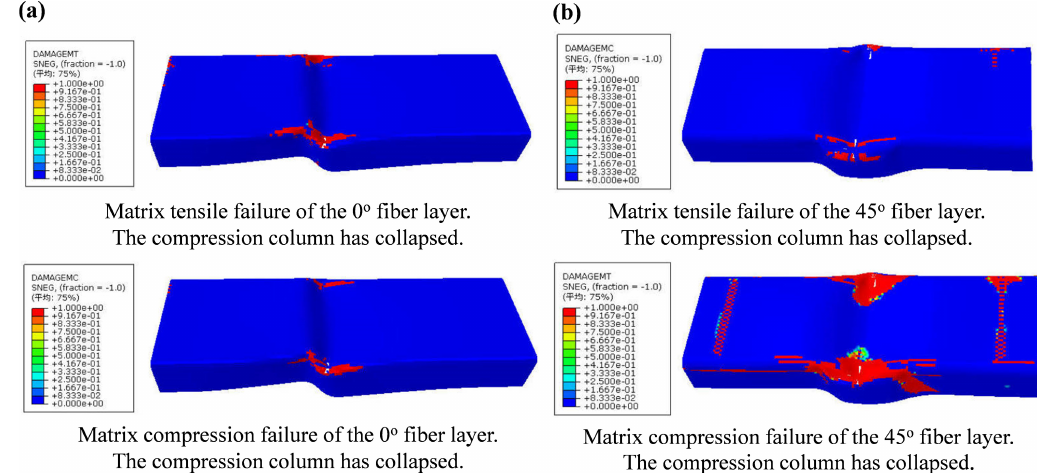
Figure 19: Matrix tensile and compression failure area distribution of compression columns at final failure state: (a) DCYG-A and (b) DCYG-B.